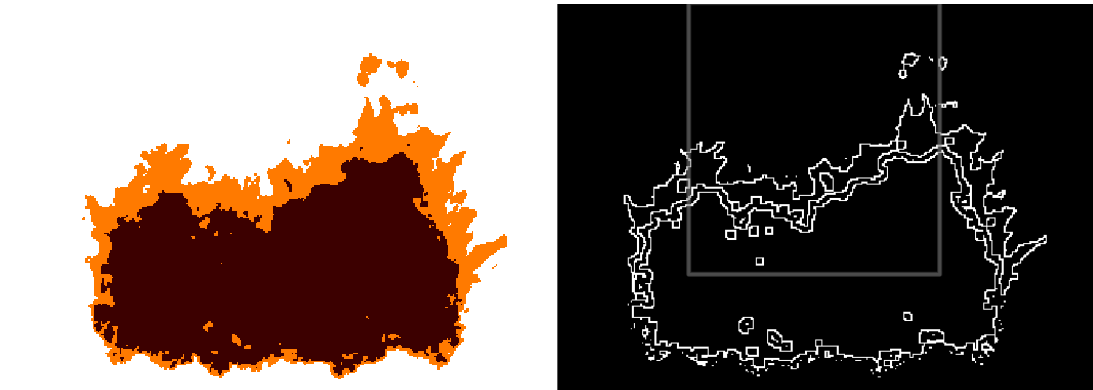
Figure 8. ( Left ): Logical mask representing all points determined to be part of the fire system, whether heated, ignited, or burnt. ( Right ): Edge detection results distinguishing the outline of three regions; heated gas, flame, and burnt area. The isotherm of the upwind side of the flaming region in the gray box is shown in Figure